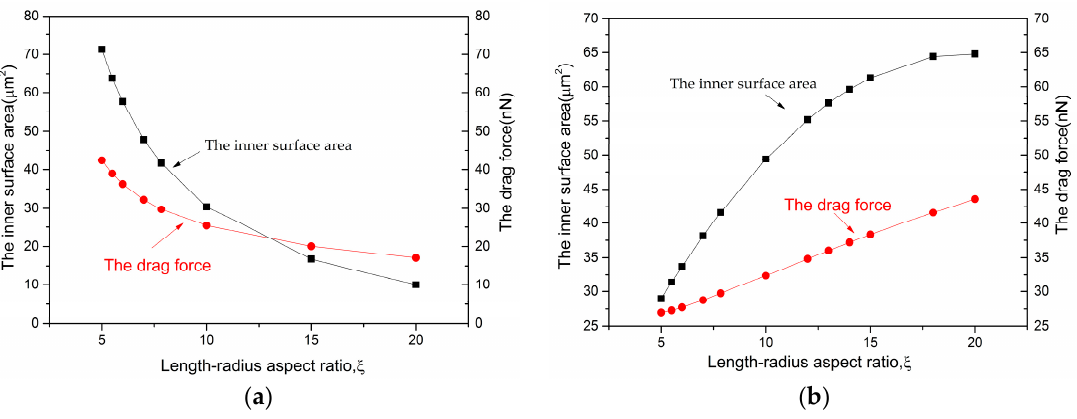
Figure 8. The inner surface area and drag force versus length-radius aspect ratio ξ : ( a ) change the radius R max , keeping L = 9.1 µ m constant; and ( b ) change the length L , keeping R max = 1.16 µ m constant.